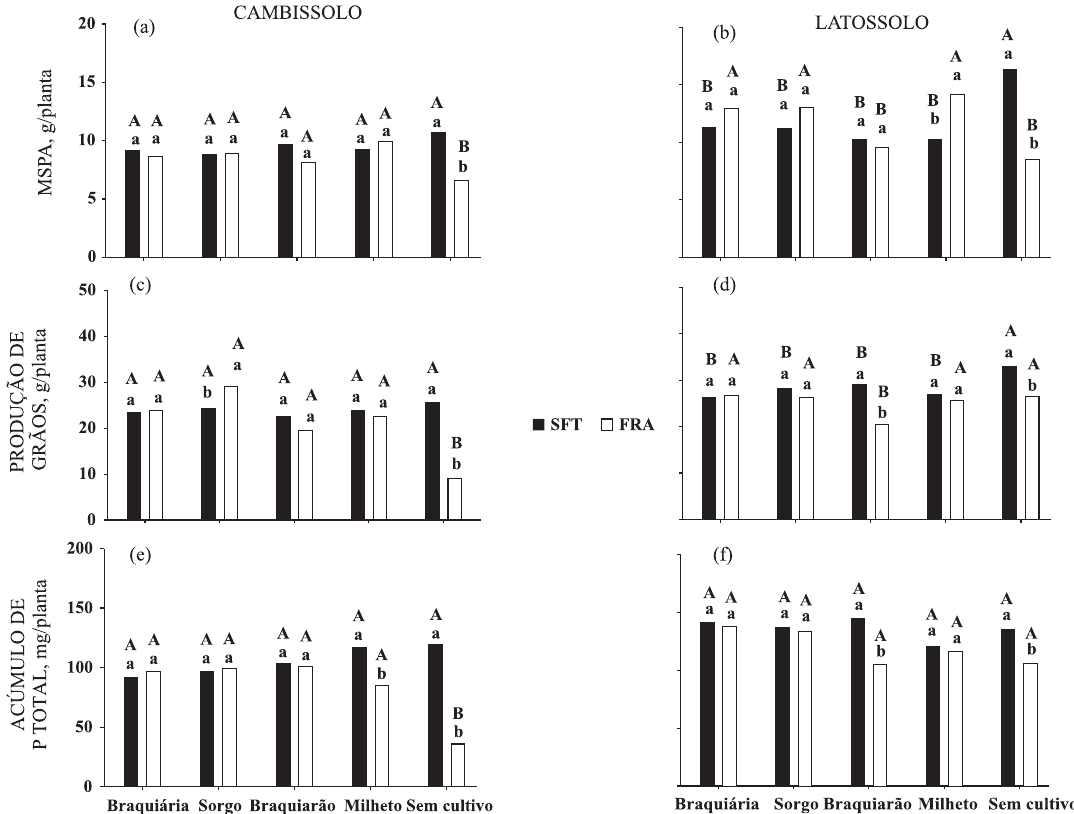
Figura 1. Matéria seca da parte aérea (MSPA) (a e b), produção de grãos (PG) (c e d) e acúmulo de P total (e e f) no feijoeiro cultivado em sucessão a gramíneas forrageiras e em solo sem cultivo, adubados com superfosfato triplo (SFT) e fosfato reativo de Arad (FRA) no Cambissolo e Latossolo. Em cada solo, médias seguidas de mesma letra minúscula, comparando as fontes de P para cada gramínea forrageira e solo sem cultivo, e maiúscula, comparando as gramíneas forrageiras e solo sem cultivo em cada fonte de P, não diferem entre si (Scott Knott, p ≤ ≤ ≤ ≤ ≤